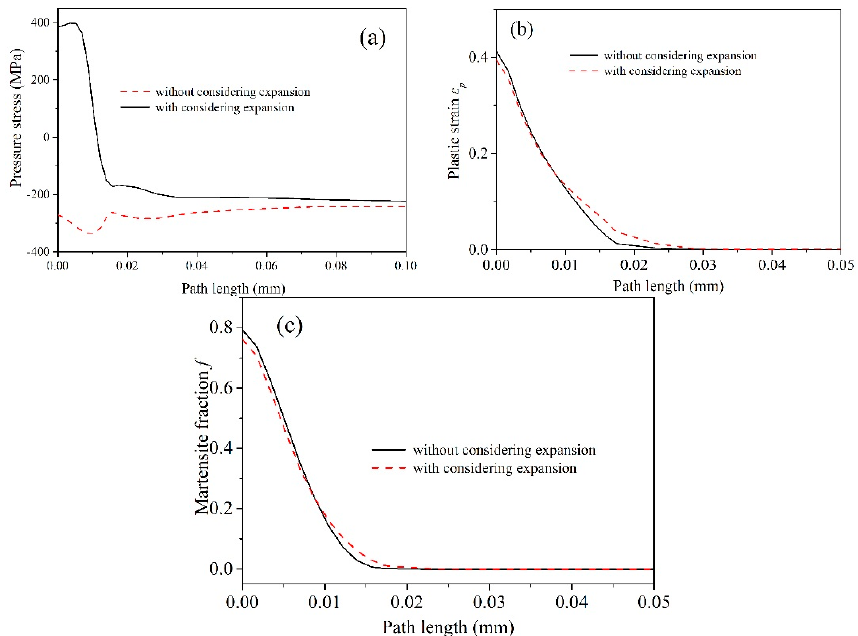
Figure 3. Stress ( a ), strain ( b ) and martensite fraction ( c ) comparisons along the path length away from the crack tip.